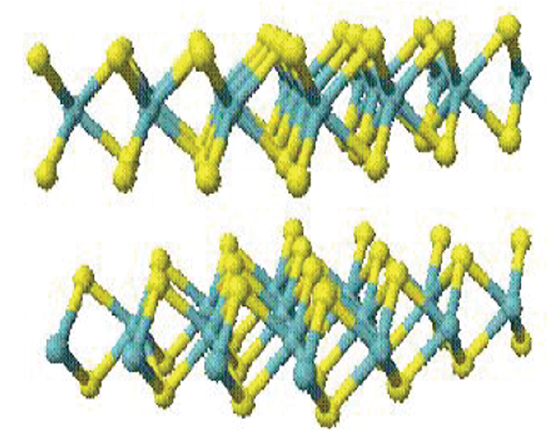
Figure 1. The molecular structure of MoS 2